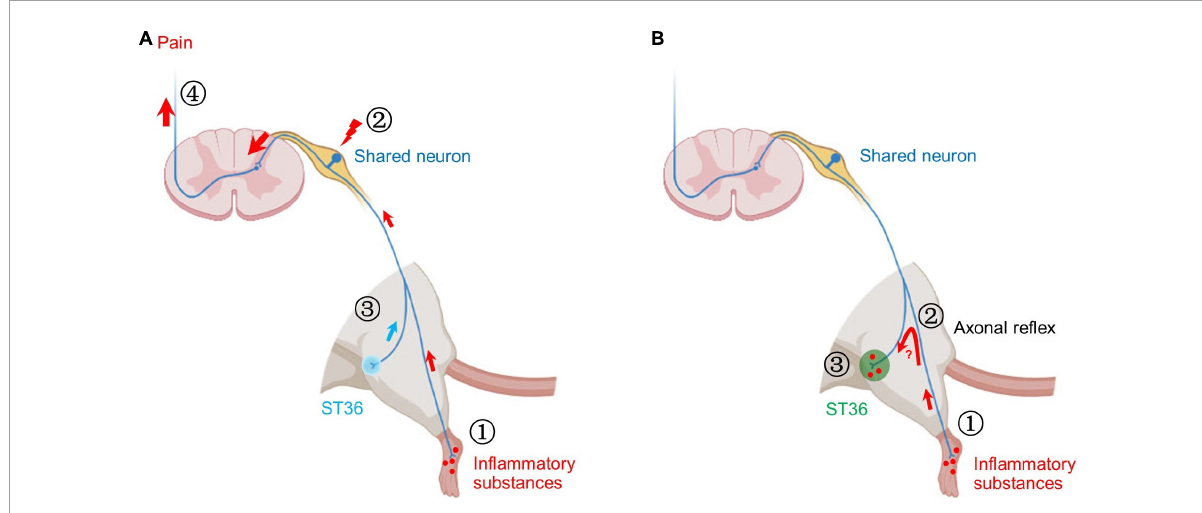
FIGURE8 Two possible mechanisms of shared neurons participating in acupoint sensitization. (A) (cid:192) The inflammatory substances induced by CFA in the hind paw plantar stimulate the terminals of shared neurons. (cid:193) The pain signals are continuously transmitted to the somata of shared DRG neurons, resulting in increased neuronal excitability. (cid:194) Mechanical stimulation of ST36 more readily activates shared neurons. (cid:195) More pain signals are transmitted to the brain. Behaviorally, the pain threshold of ST36 acupoint decreased. (B) (cid:192) The inflammatory substances induced by CFA in the hind paw plantar stimulate the terminals of shared neurons. (cid:193) By the axonal reflex mechanism, the nerve impulses are transmitted to ST36 acupoint via axon bifurcation. (cid:194) The persistent nerve impulses promote the release of pro-inflammatory molecules from the nerve terminal and recruit mast cells to aggregate, degranulate, etc. Locally enhanced neuroimmune responses lead to lower pain thresholds and enlarged receptive field of ST36